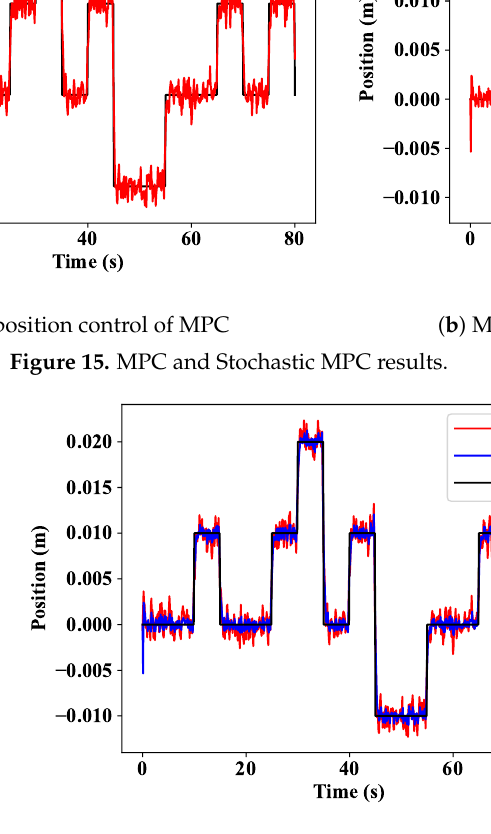
Figure 16. Controllers